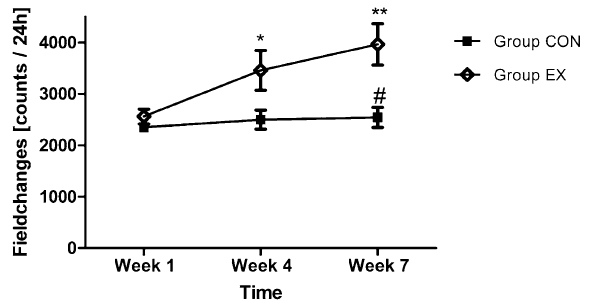
Figure 8. Field changes [counts] per 24 h Week 1 vs. Week 4 vs. Week 7. The field changes in the control group (Group CON) remained constant over the study period of 7 weeks. Spontaneous cage activity (SCA) significantly increased within the exercise group (Group EX) during the experimental period (*p < 0.05 and **p < 0.005 vs. Week 1) and was significantly higher than the SCA of the Group CON ( # p < 0.05 vs. Group CON same week).